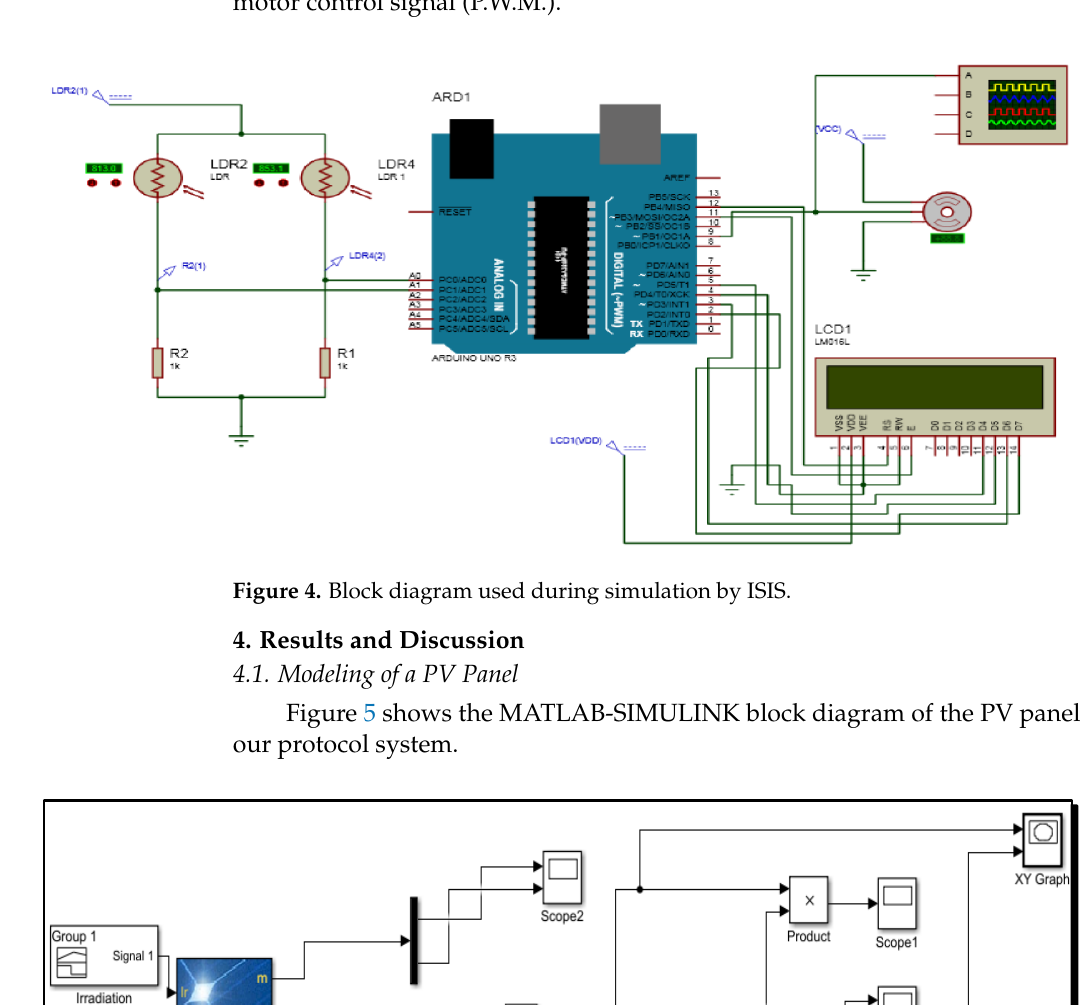
( b ) Figure 3. ( a ) Servo motor electrical diagram; ( b ) Position of the servo motor compared with the Arduino card. Table 1. Characteristic parameters of the servomotor used in the construction of the prototype of the single ‐ axis tracker.